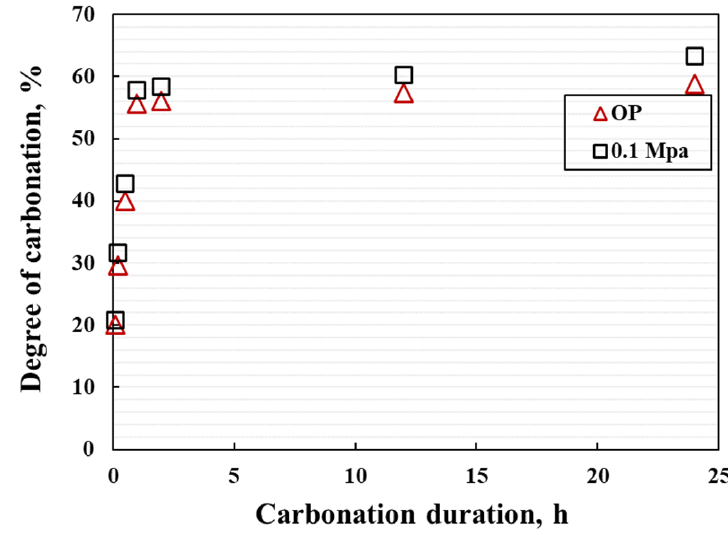
Figure 12. DOC variation of the coating during the carbonation.